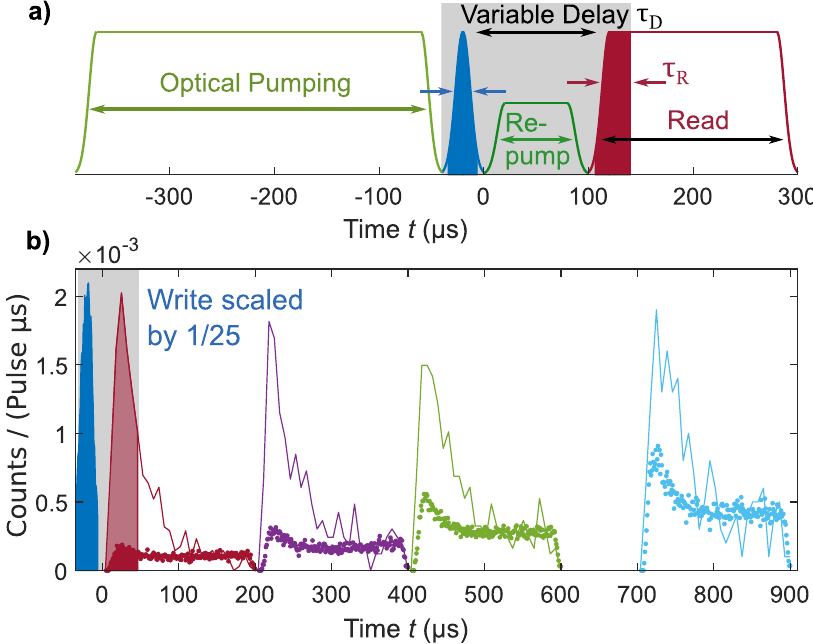
Fig. 2 Experimental pulse sequence and temporal shape of detection events. a Illustration of smoothened write, read and optical pumping pulses, variable delay between write and read, and optional repump for delayed readout. The solid areas represent integration windows used in the analysis. b Blue area — detected counts during heralding write pulses (31 μ s, scaled 1/25). Solid curves — detected counts during read pulses (200 μ s, delayed 10 to 710 μ s) conditioned on the heralding write count (averaged over 7 μ s bins). Dotted curves — the read noise level in the absence of write pulse (1 μ s binning). Source data are provided as a Source Data fi